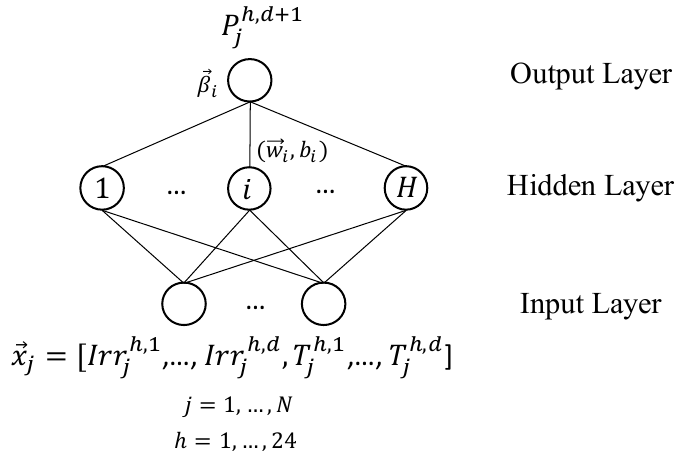
Figure 6. The Architecture of ELM model.